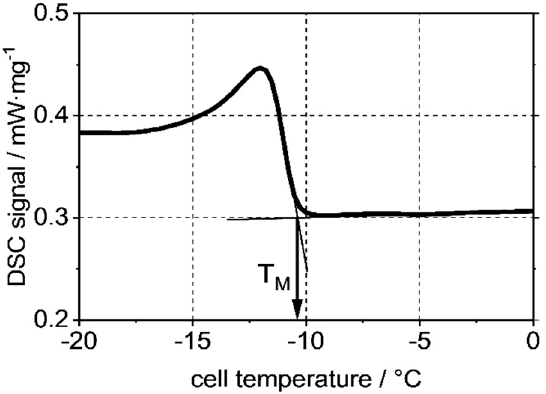
Figure 5. DSC signal for a commercial paraffin oil at cloud point temperature [27].